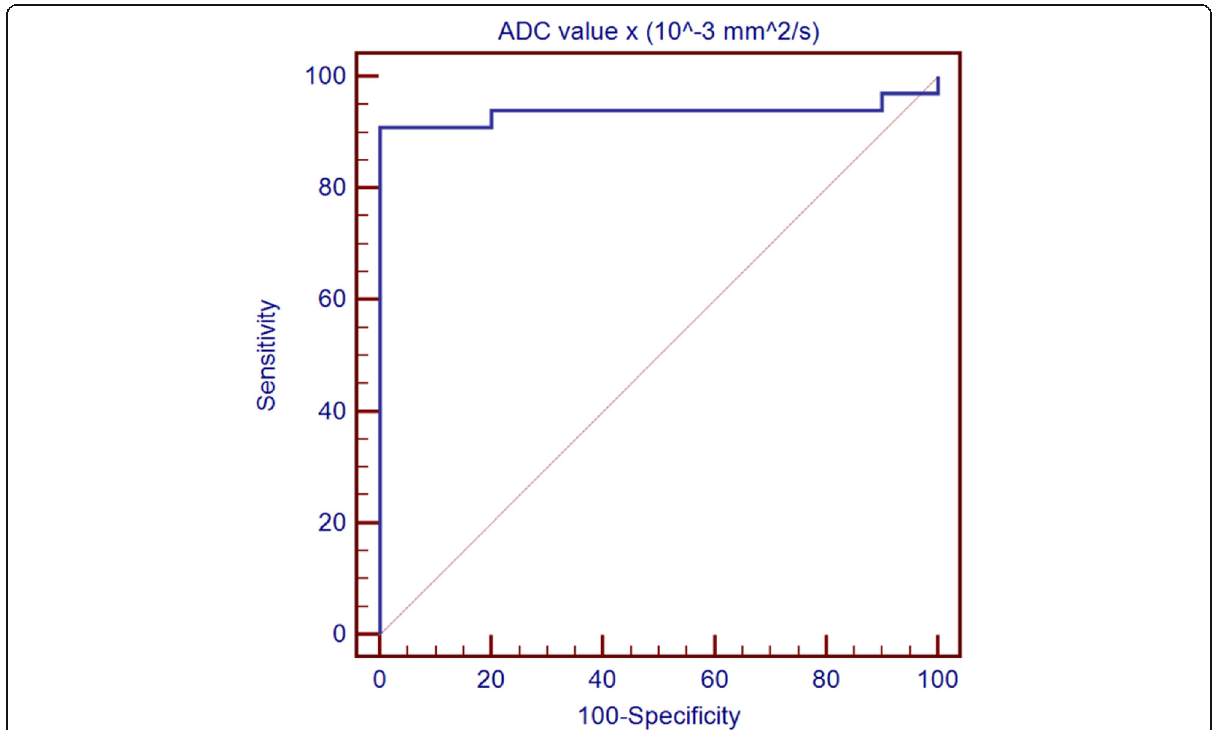
Fig. 2 Receiver operating characteristic curve (ROC) for the predictive value of ADC in differentiation between benign and malignant tumors